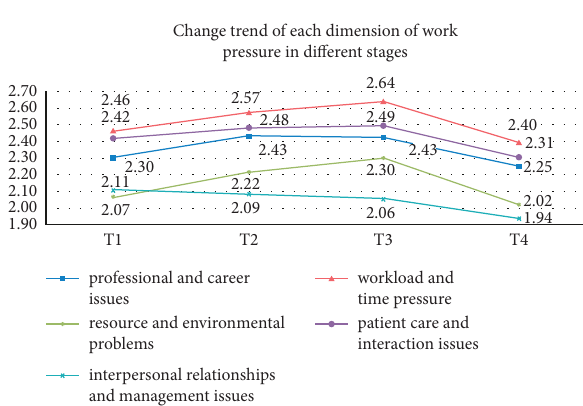
Figure 3: Trends of job stress in each dimension of the survey respondents in diferent